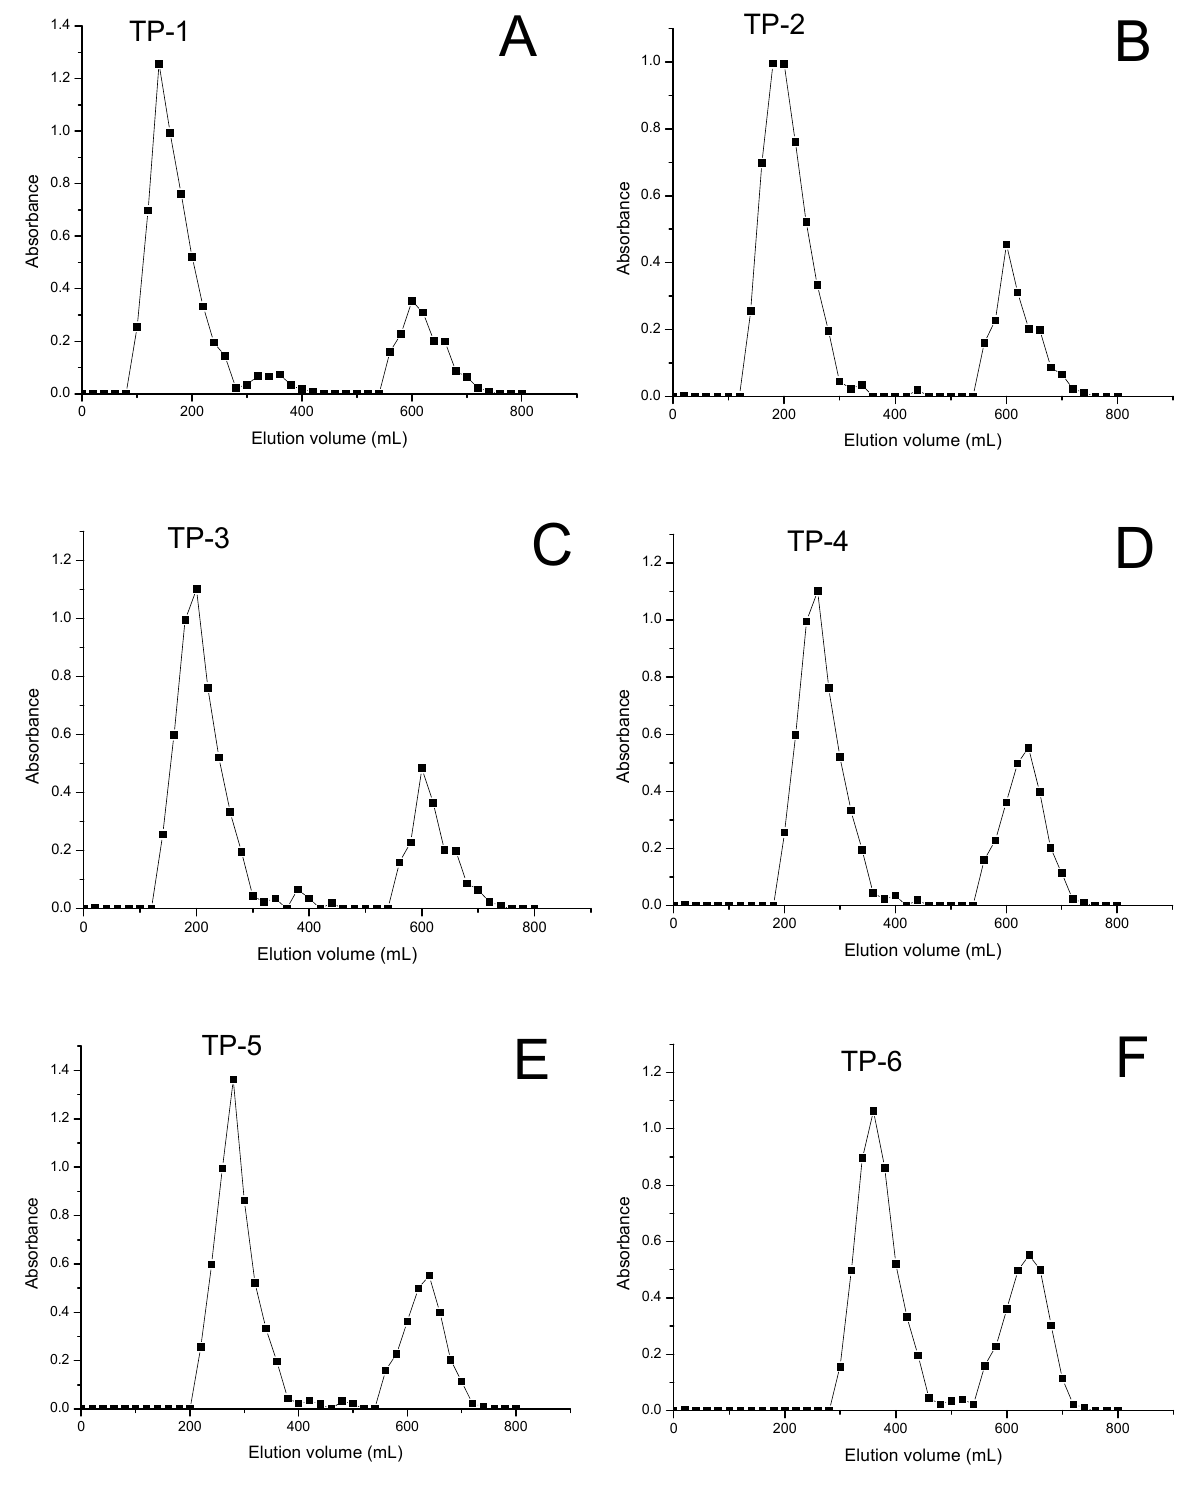
Figure 1. Elution profile by Sephadex G-150. Absorbance at 490 nm from the phenol-sulfuric acid assay. Column void volumes were 0-50 mL and 550 mL-600 mL. A : elution profile of TP-1; B : elution profile of TP-2; C : elution profile of TP-3; D : elution profile of TP-4; E : elution profile of TP-5; F : elution profile of